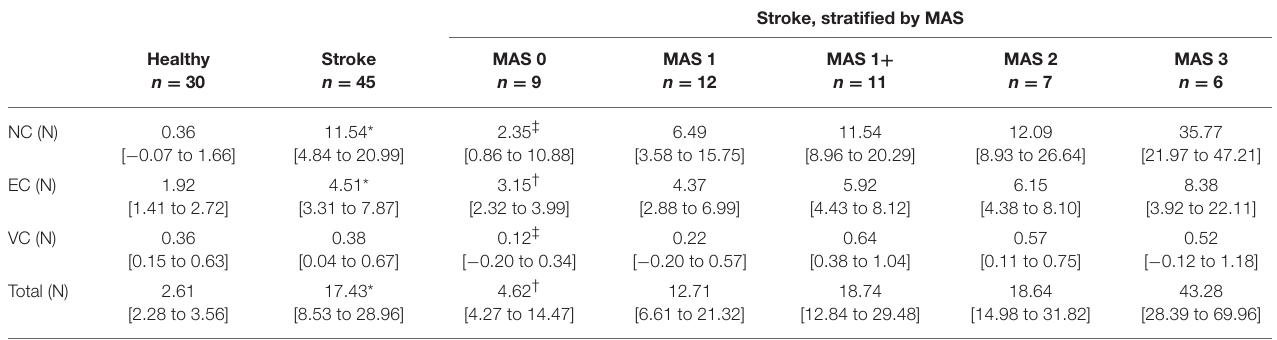
TABLE 3 | Neural and non-neural components of wrist hyper-resistance in healthy subjects and patients with chronic stroke.